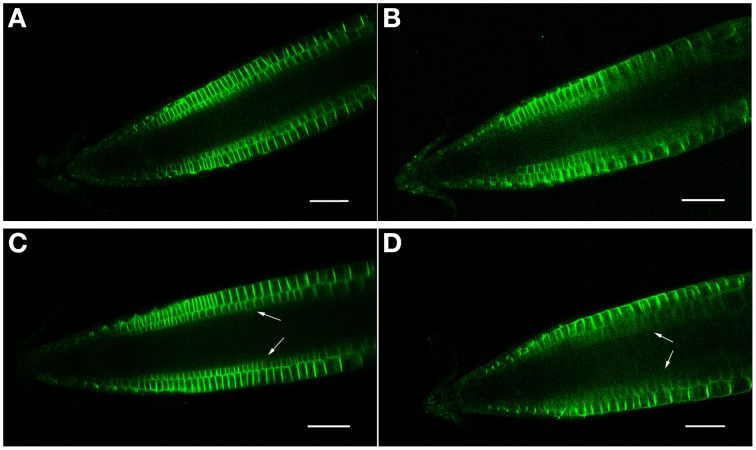
(A–D) PIN2 (PIN2-GFP) confocal localization in Arabidopsis roots, ± salt. (A,C) Control roots (no salt treatment) after 12 and 24 h, respectively. (B,D) Roots treated for 12 and 24 h, respectively, with 150 mM salt. Note that a 24 h salt treatment results in a diminishment of PIN2-GFP expression in the cortical layer directly beneath the epidermis (arrows). Scale bar = 50 μm, n = 6 roots for the control and seven for each treatment.